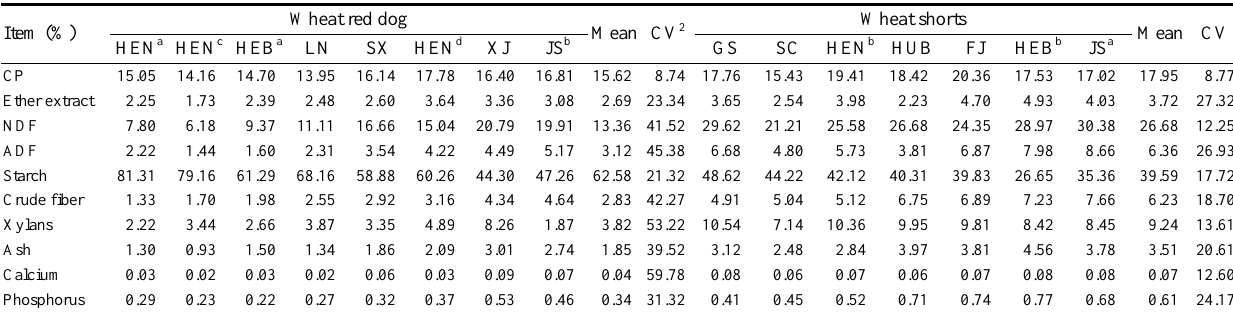
Table 1. Chemical composition of fifteen samples of wheat shorts and red dog used in experiment 1 (% DM) 1 Item